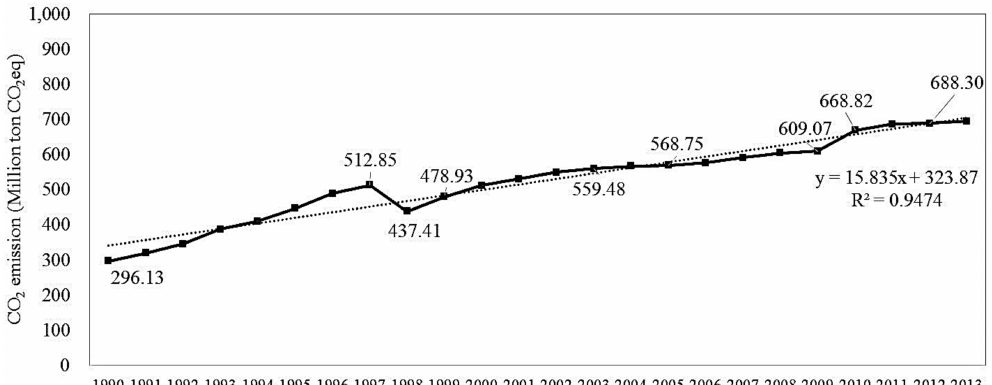
Figure 2. Total greenhouse gas emission in all sectors of